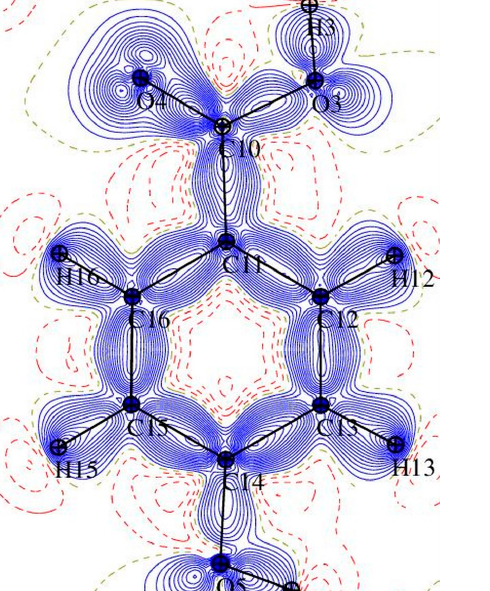
Figure 5. Laplacian of the electron density in fragments of 2 : ( a ) p-hydroxybenzoic acid, ( b ) C2-N1-C6 plane, and ( c ) C7-N1-C8 plane.